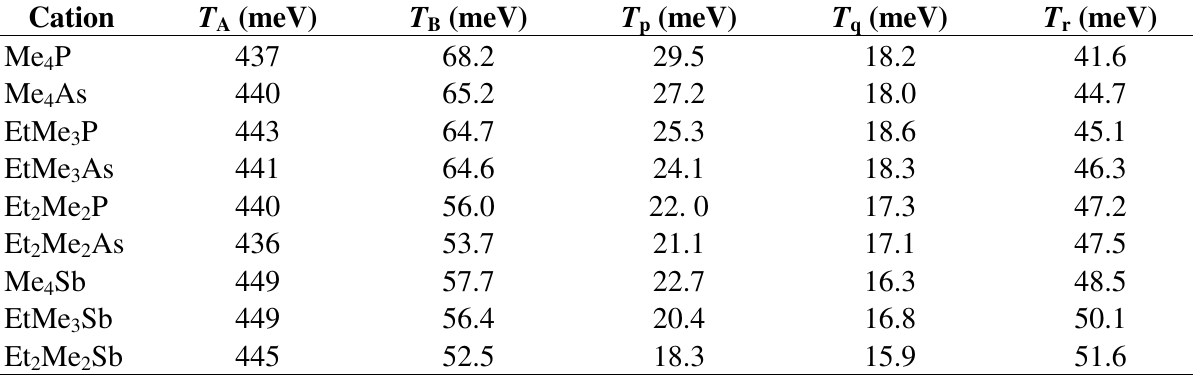
Table 2. Intermolecular highest occupied molecular orbital (HOMO)-HOMO